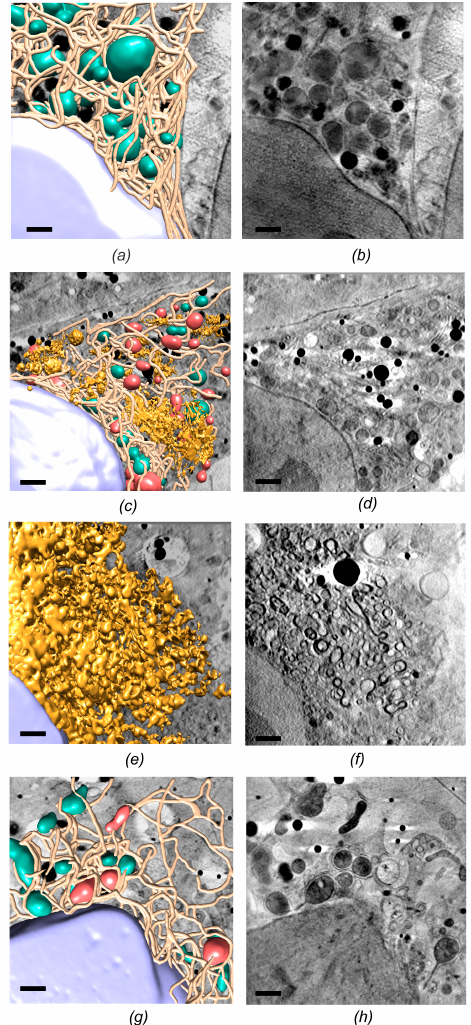
Figure 2. Three-dimensional reconstruction of whole-cell volumes by cryo-SXT. Control ( a , b ); HCVtcp-infected cell cytoplasm at different stages of HCV infection: early infection ( d , e ) and late infection ( e , f ); and HCV replicon-bearing cell lines treated with antiviral compounds for 7 days ( g , h ). Manual segmentation of the surface boundaries identifying organelles is shown in the left column ( a , c , e , g ), with normal mitochondria displayed in green, abnormal mitochondria in red, nuclear envelope in purple, endoplasmic reticulum in brown, and membranous web in gold. Volume slices of the tomograms are shown in the right column ( b , d , f , h ). Scale bar corresponds to 1 µm.